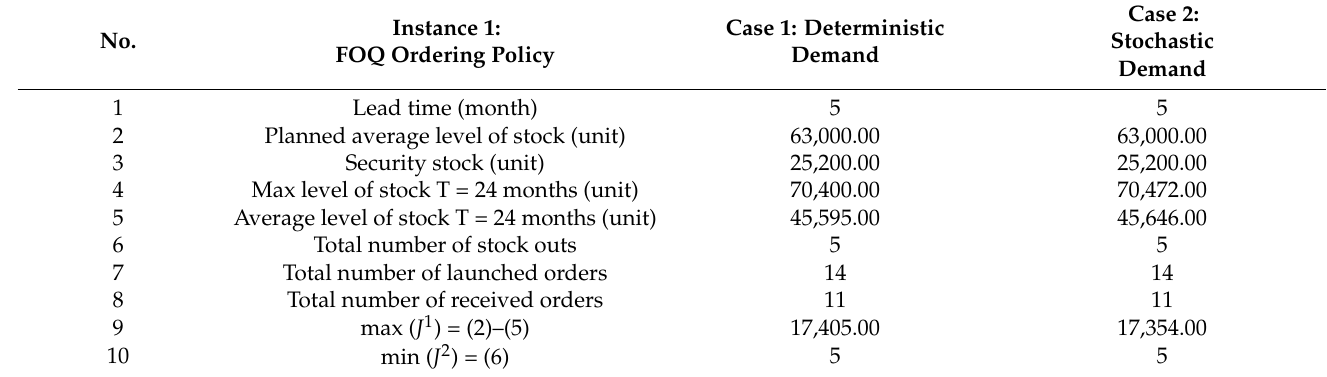
Table 2. Numerical results of Case 1 and Case 2 for Instance